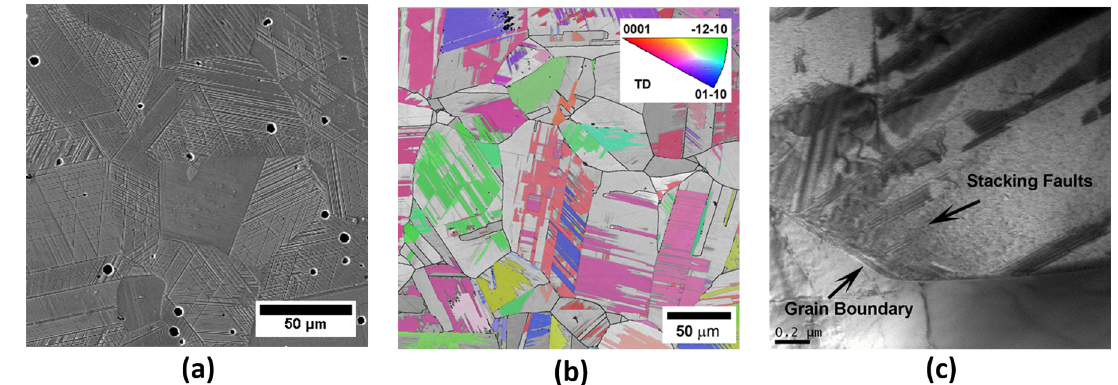
Figure 1. Micrographs of the ST sample: (a) SEM-SE, (b) Pattern Quality Map overlaid with a Martensite IPF Map (EBSD), (c)